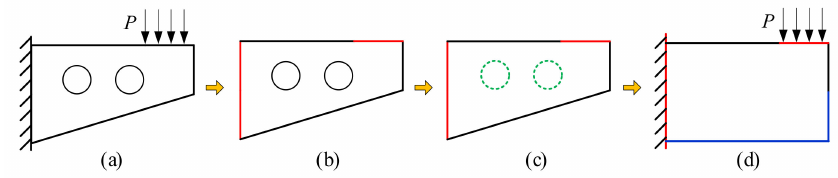
Figure 2. Establishing the envelope model. ( a ) a cantilever bracket, ( b ) the contrained and loaded areas remain unchanged, ( c ) the lightening holes are removed, ( d ) the regular outline of the bracket.